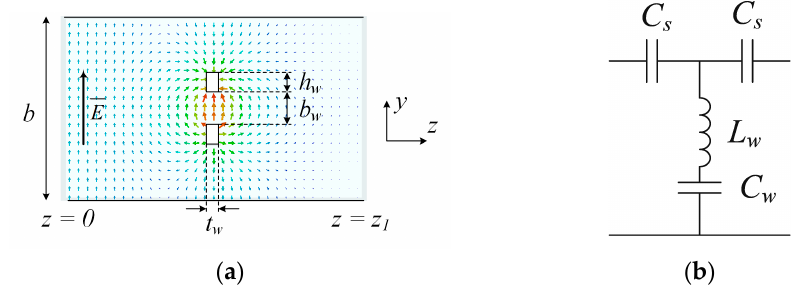
Figure 3. E-field simulation and electrical model of the analyzed generic iris: ( a ) Field distribution along yz plane, ( b ) electrical model for a thick iris.